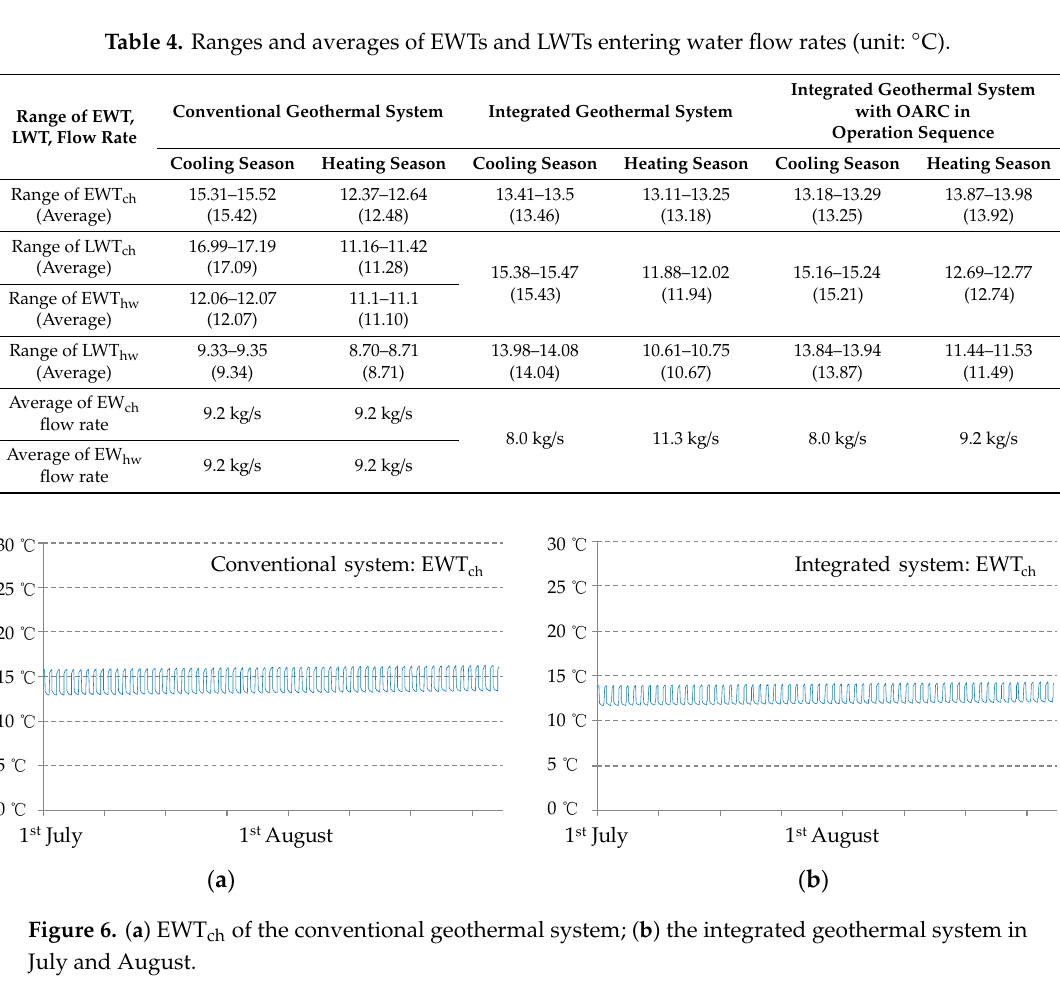
Figure 6. ( a ) EWT ch of the conventional geothermal system; ( b ) the integrated geothermal system in July and August.